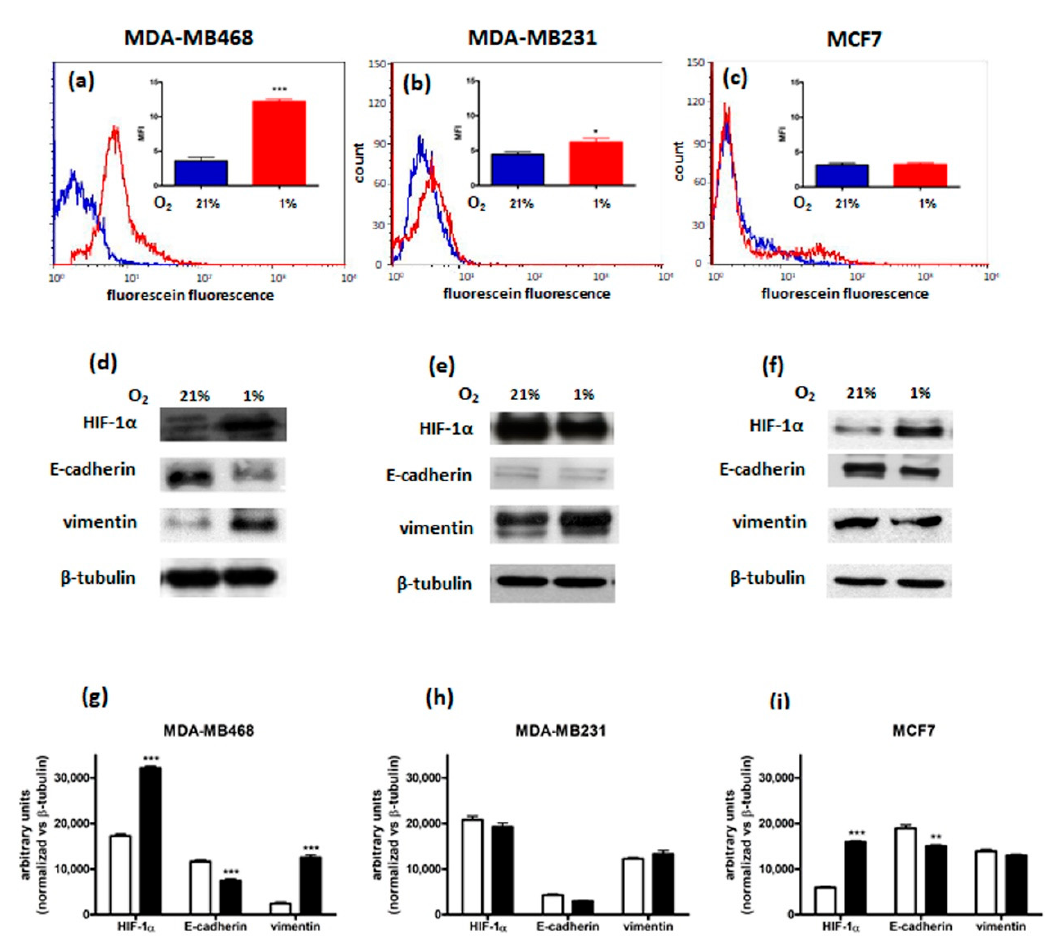
Figure 1. MDA − MB468, MDA − MB231 and MCF7 cells response to 48 h hypoxia (O 2 1%). ( a – c ): ROS levels (blue: O 2 21%; red: O 2 1%). Fluorescence intensity was quantitated based on the Median Flu-